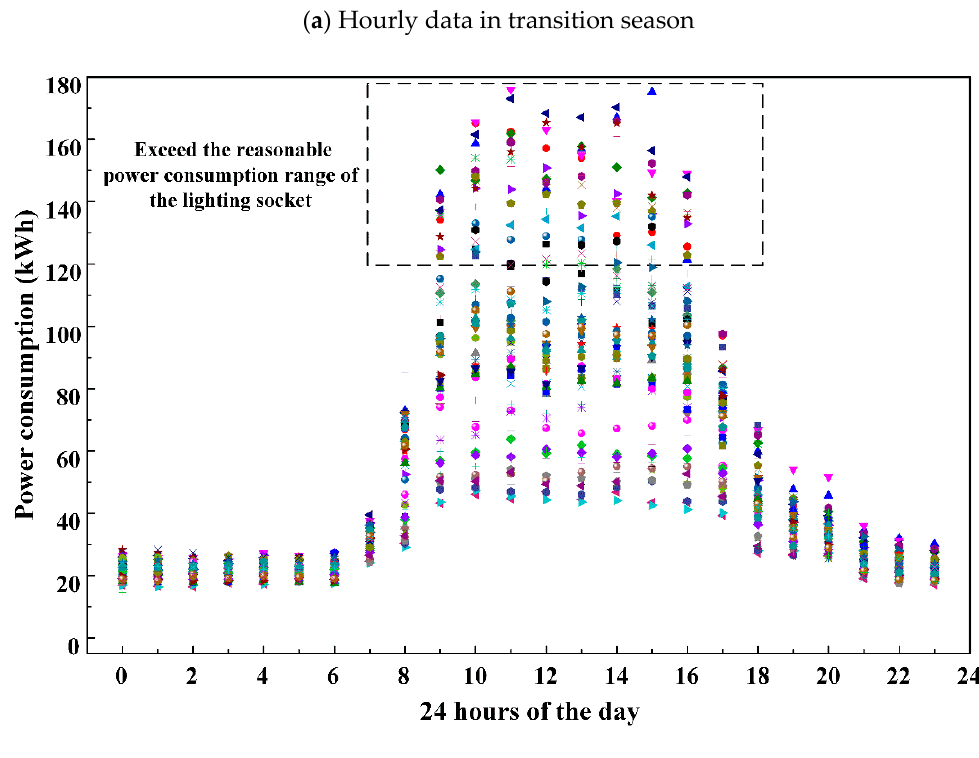
Figure 5. Time-series characteristics of the electricity consumption of lighting